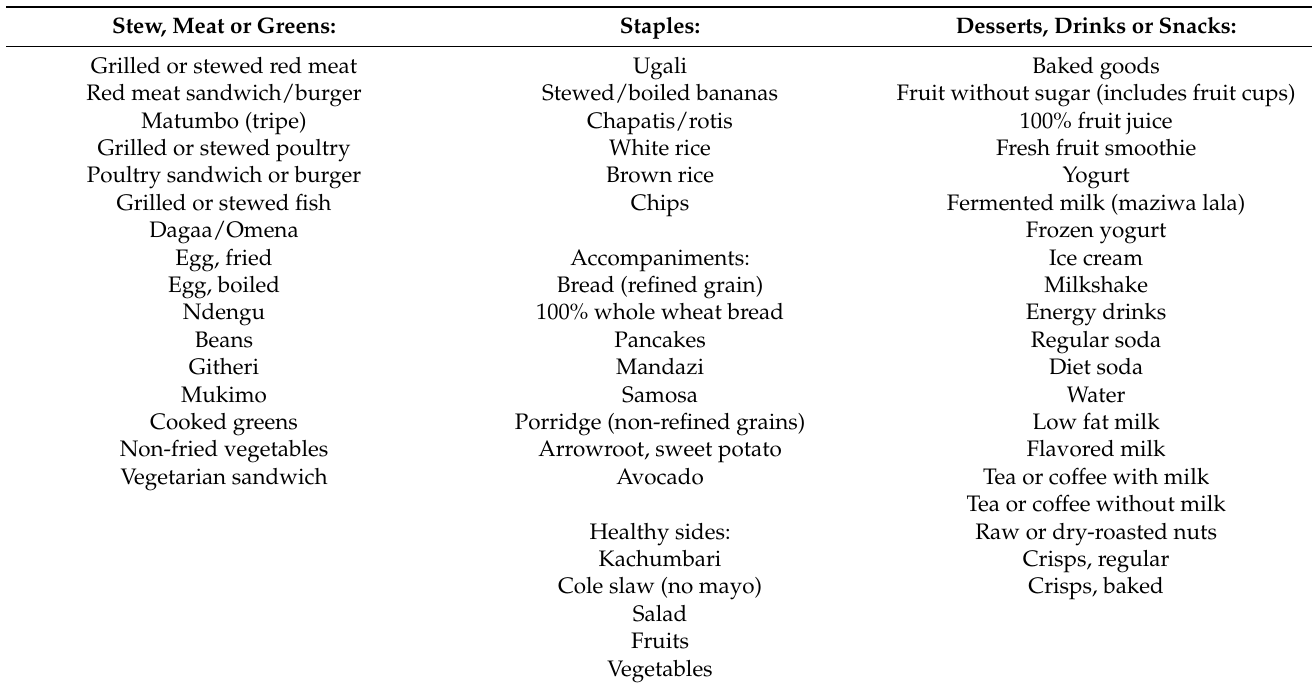
Table A3. Prepared food places’